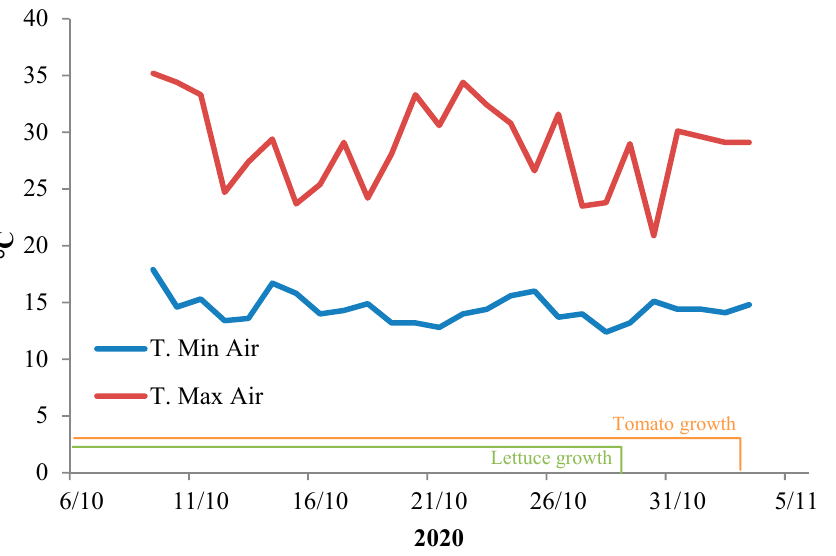
Figure 1. Daily average maximum and minimum temperatures of the air inside the greenhouse during nursery trials.